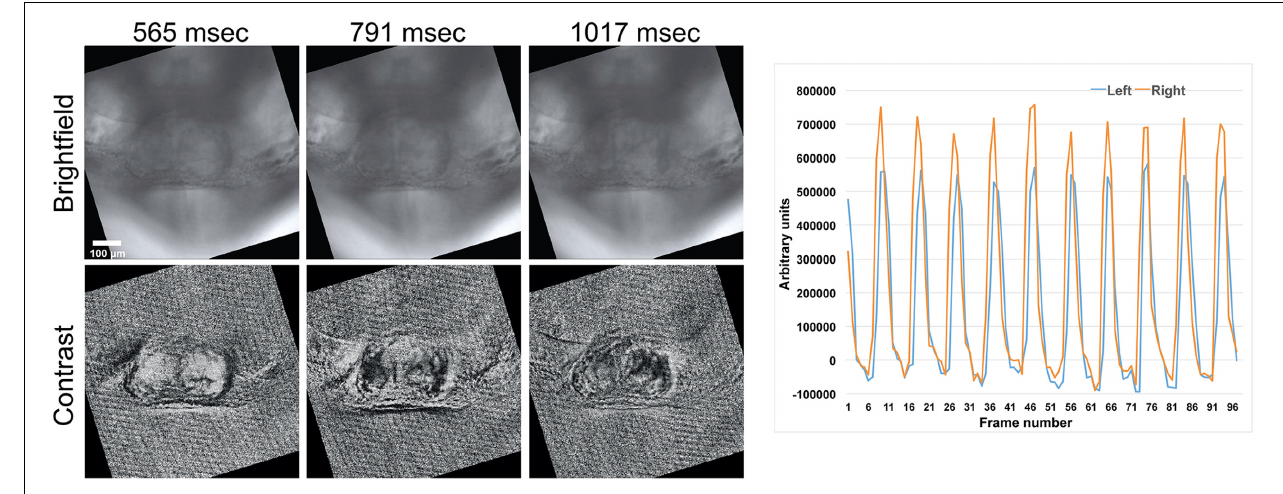
FIGURE 5 | A comparison between normal brightfield (top row, “Brightfield”) and temporally normalized images (bottom row, “Contrast”) obtained at different time points. Large regions with uniform intensity (either black or white) within a single frame indicate parts of the